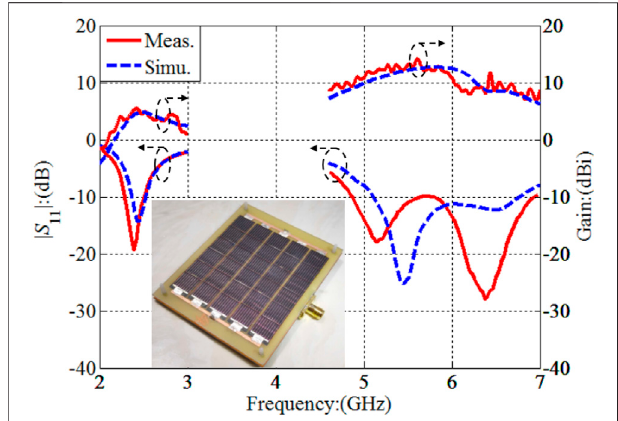
FIGURE9| Themeasuredandsimulated S -parametersandgainsofthe